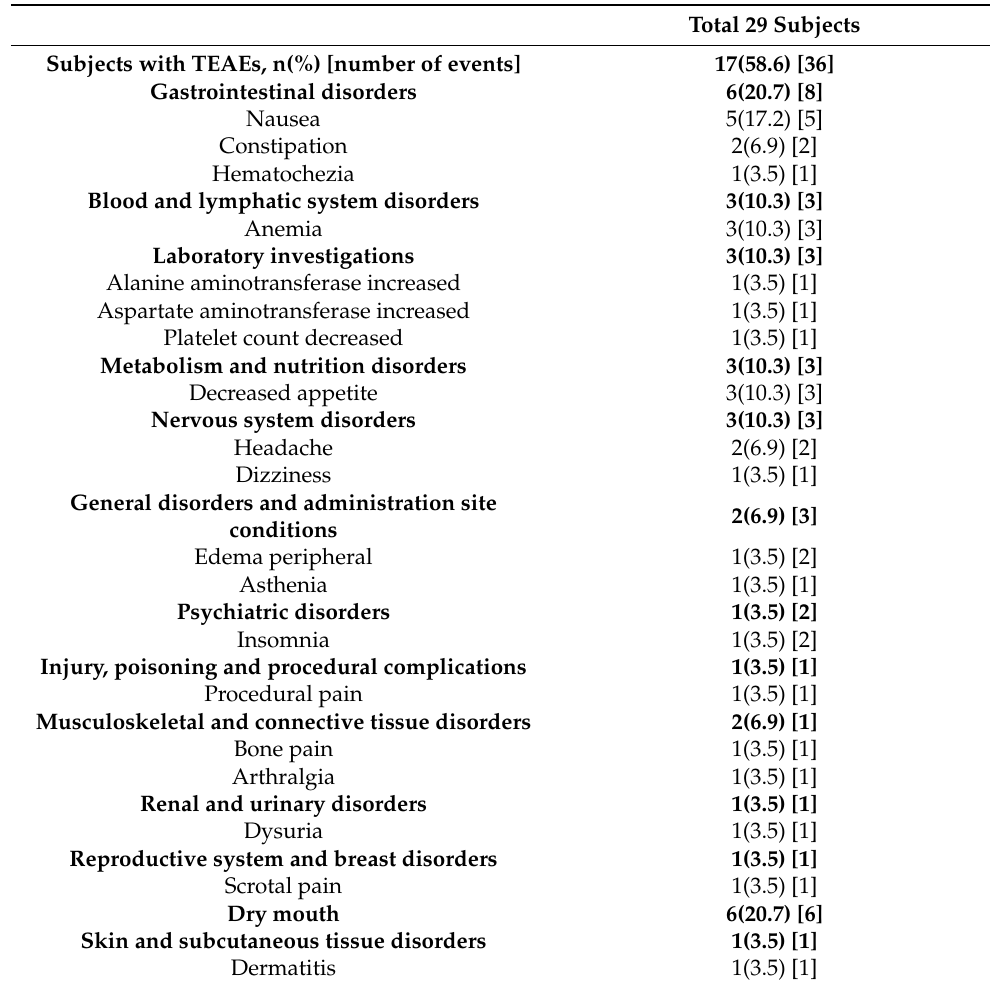
Table 3. Treatment emergent adverse events (TEAEs) according to system organ class (SOC) and preferred term (PT).